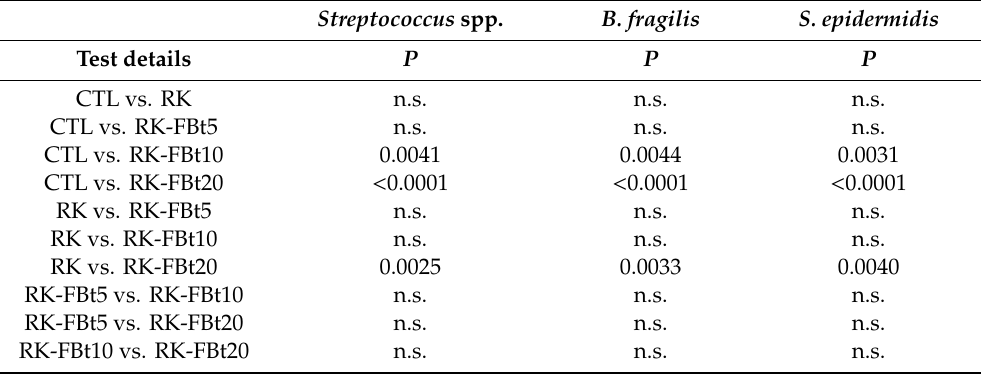
Table 1. Results of inter-group statistical significance of direct contact test (DCT) using Kruskal–Wallis test followed by Dunn’s post hoc